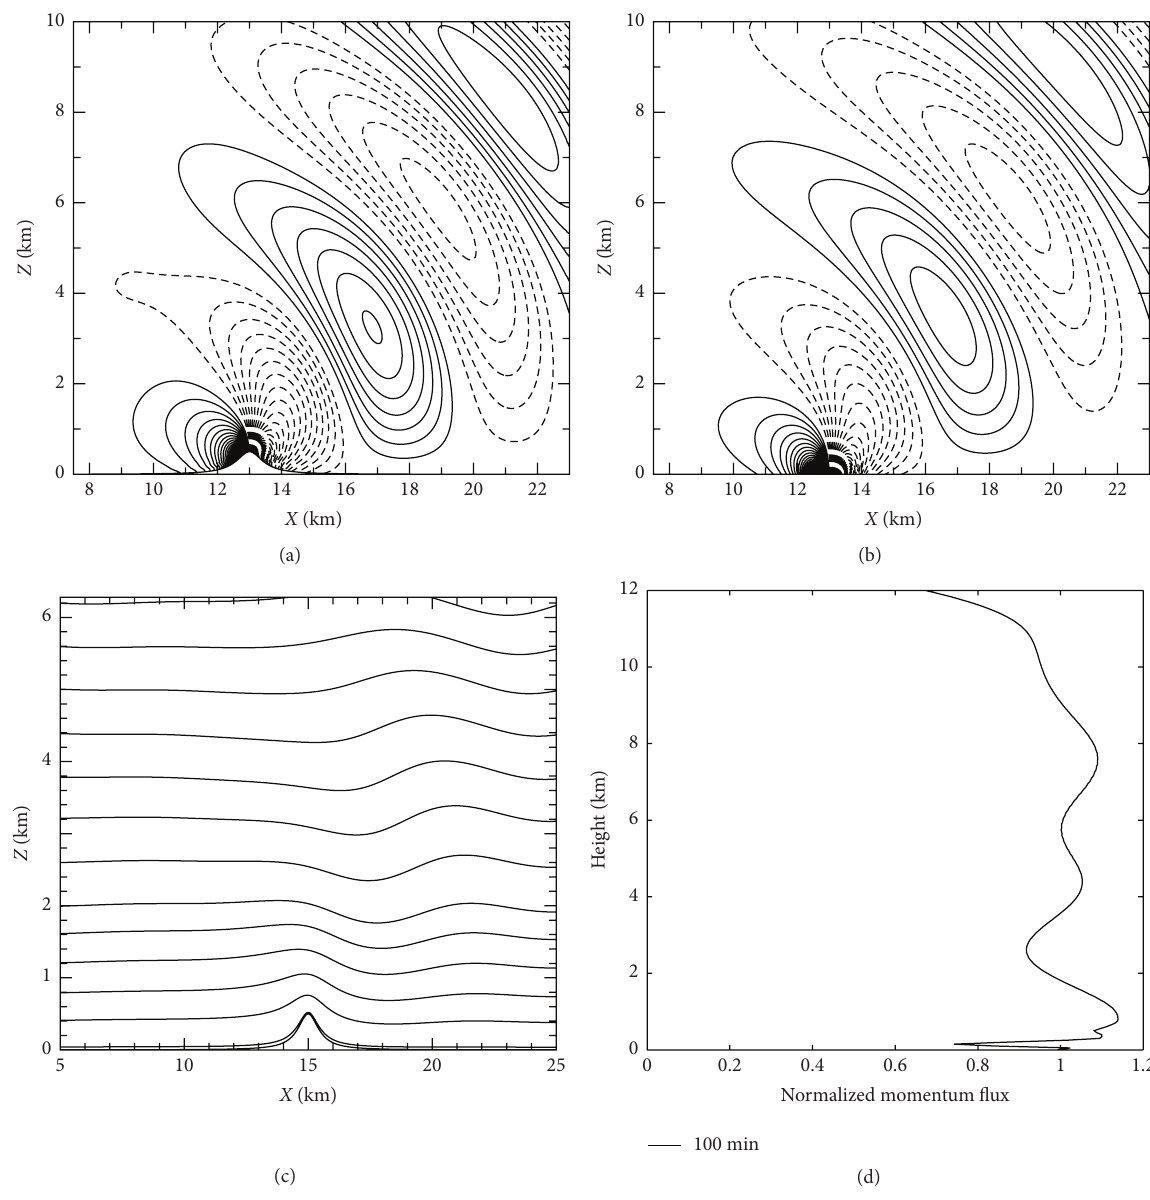
Figure 5: Same as Figure 3, but for case D1. Contour interval is 0.2 ms −1